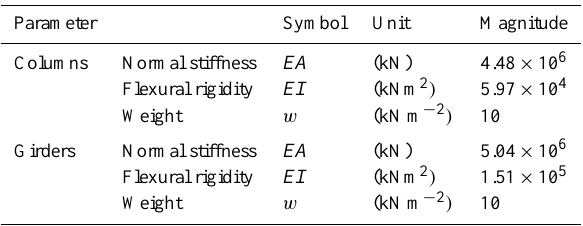
Table 2. Mechanical property of superstructure for validation of SSI Model.